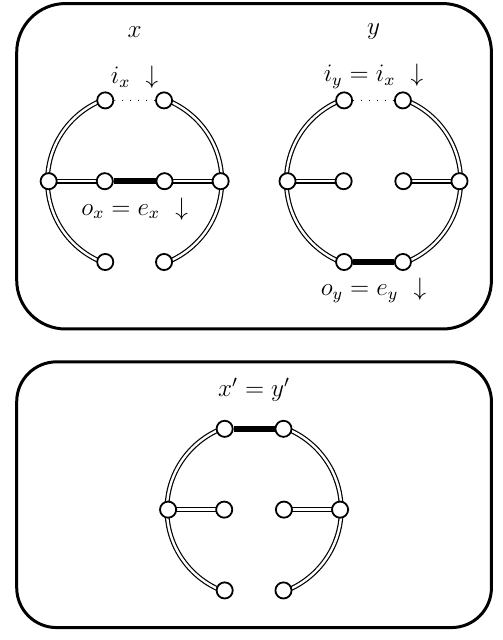
Figure 7: Case 4. a .i, case 4. b .i and case 4. c .i.